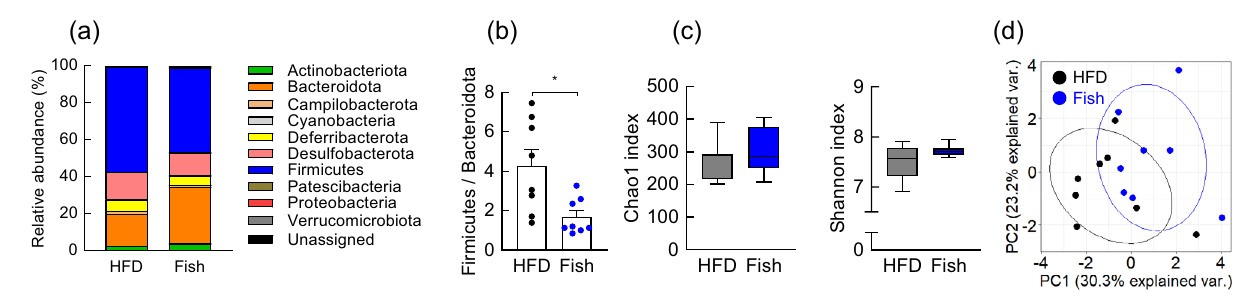
Figure 4. Fish oil altered the gut microbiota composition. ( a – d ) C57BL/6J male mice were fed either a high fat diet (HFD) or a modified HFD diet (Soybean oil in HFD was replaced with fish oil (Fish)) for 8 weeks. Gut microbial composition was evaluated for the determination of the relative abundance of microbial phyla ( a ), Firmicutes to Bacteroidota ratio ( b ), Chao1 and Shannon index at the OTU level ( c ), and principal coordinate analysis (PCoA) at the phylum level ( d ) of mice fed HFD or a modified HFD (Fish) in feces (n = 7–8 mice for each group). * P < 0.05 (Mann–Whitney